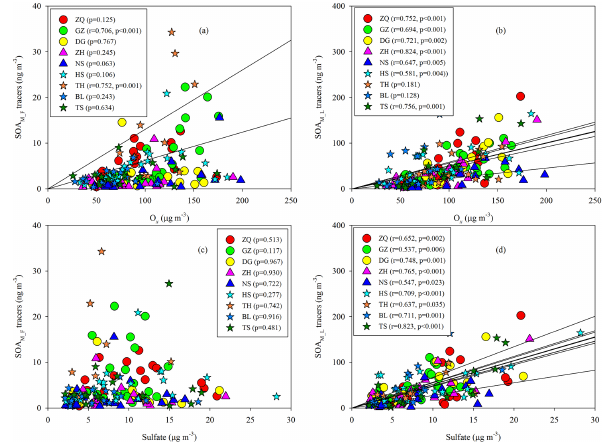
Figure 5. Correlations of SOA M_F and SOA M_L tracers with O x (a, b) and sulfate (c, d) .